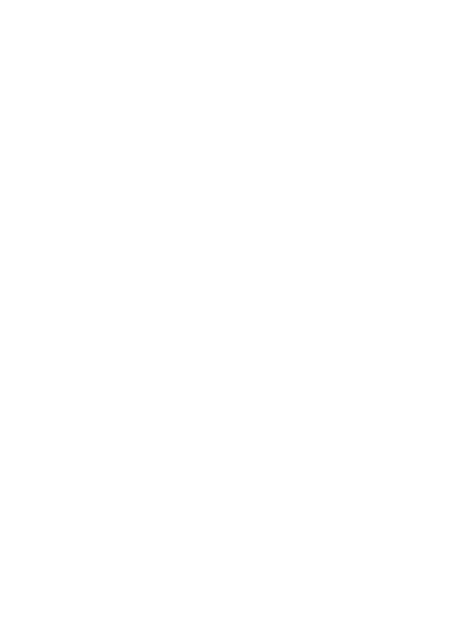
Figure 2. Mortality of Leptopharsa gibbicarina third-instar nymphs by four BPUs to level LC 90 appli- cation on oil palm leaves. Treatment means (percent mortality ± SEM) with different letters show significant differences by Tukey’s HSD test at the p < 0.05 level.